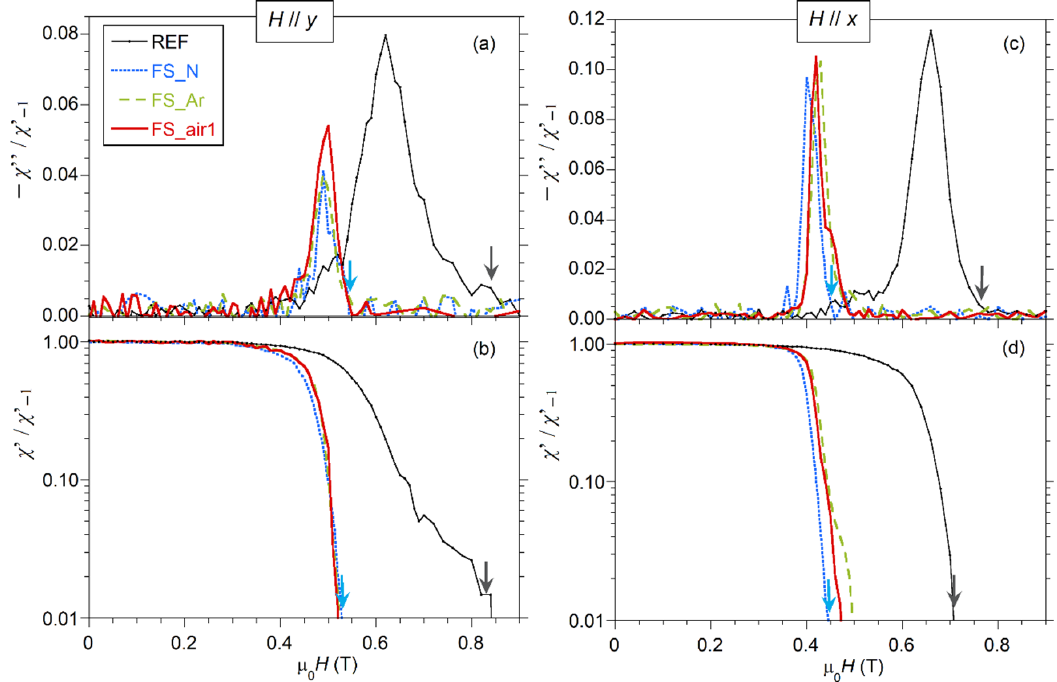
Figure 7. Components of the χ ac : χ ’’ ( a , c ) and χ ’ ( b , d ), scaled by χ ’ −1 , as a function of the DC magnetic field, μ 0 H , applied parallel to the y -axis ( a , b ) or the x -axis ( c , d ), at T = 5 K, f = 10 Hz and μ 0 h 0 = 10 μT measured in descending fields from the initial field 1.5 T. The arrows mark μ 0 H c3 values for samples REF (black arrow) and FS_N (blue arrow), derived as explained in the text.